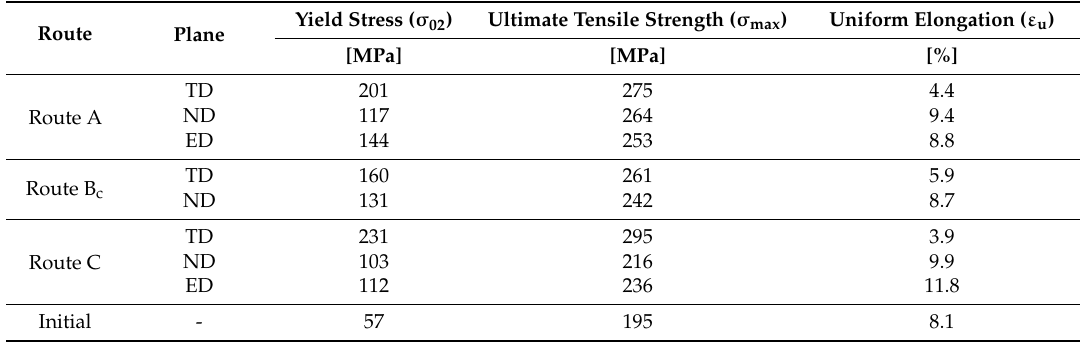
Table 2. Mechanical characteristics as a function of the processing route and direction of the tensile testing.